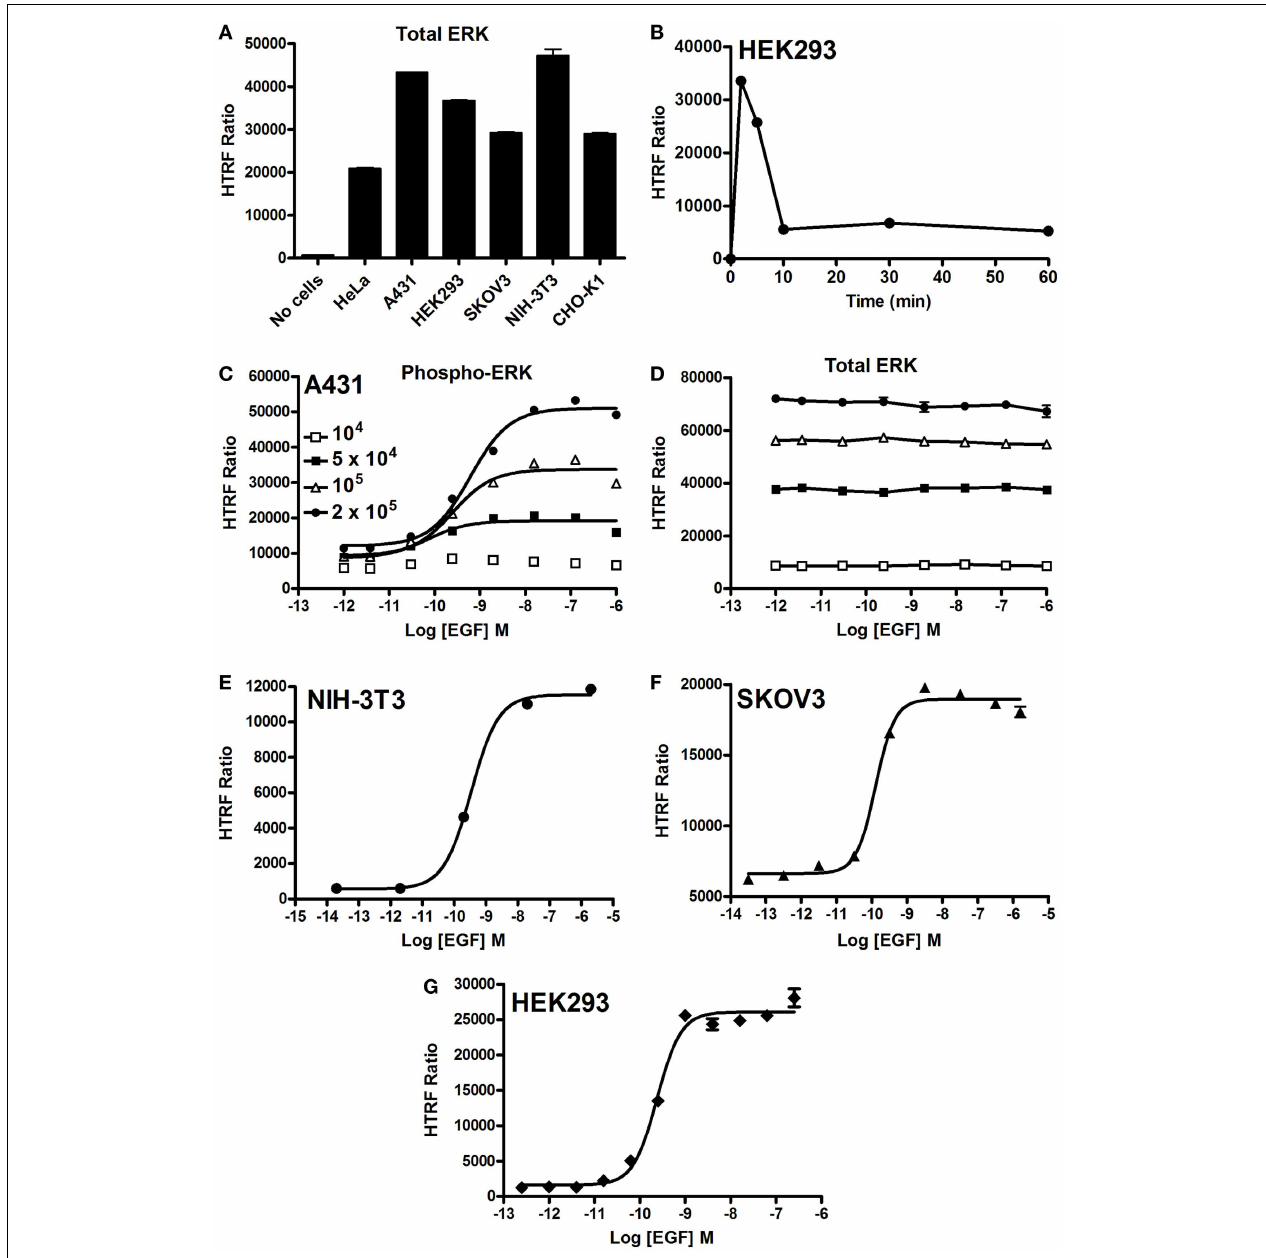
EGF as indicated. EGF-induced Phospho-ERK1/2 in various cell lines endogenously expressing EGFR: NIH-3T3 (E) , SKOV3 (F) , and HEK293 (G) cells (10 5 cells/well) stimulated for 5min with increasing concentrations of EGF before HTRF measurements were performed using the one-plate protocol.The data are mean ± SEM of three independent experiments performed in duplicate.